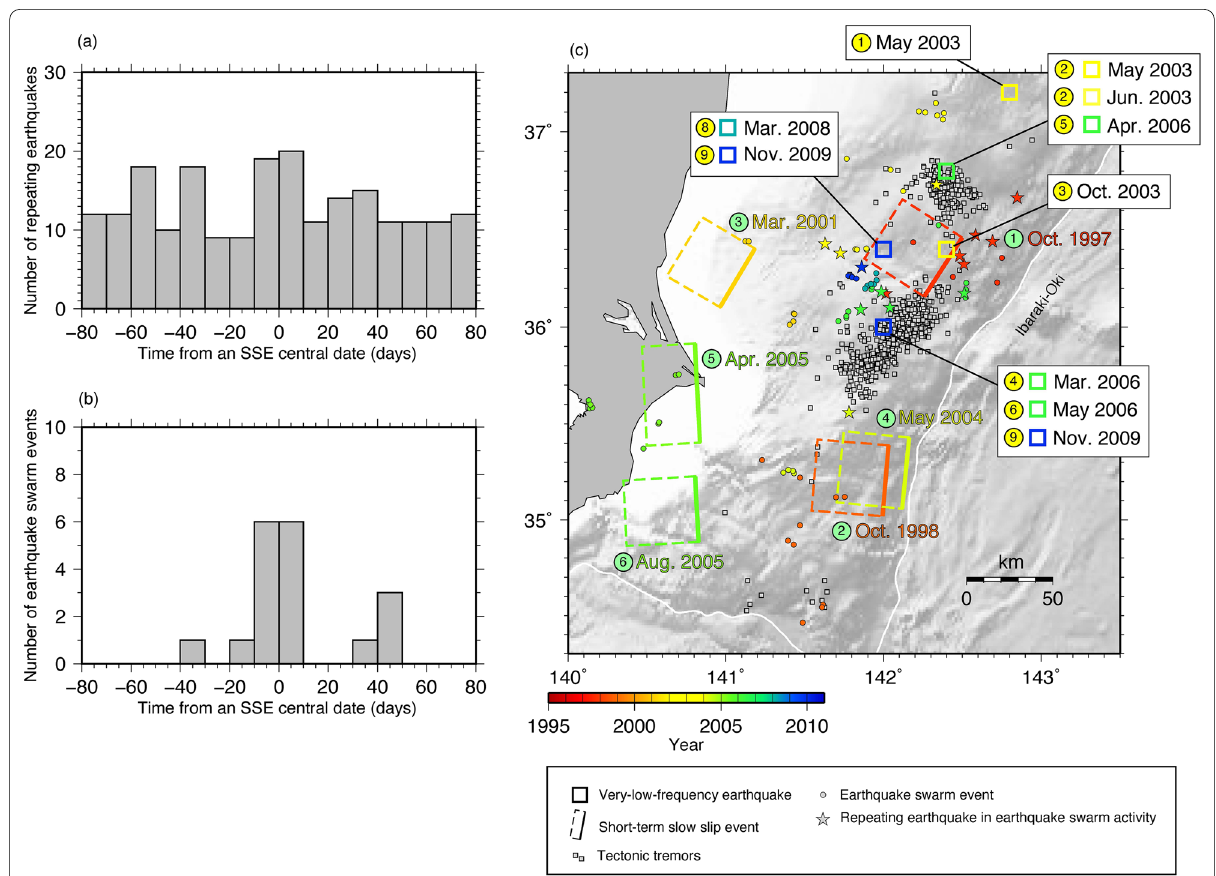
Fig. 8 Coinciding events of repeating earthquakes, earthquake swarms, and slow earthquakes in the southern Japan Trench. a and b Histograms of the occurrence times of repeating earthquakes and earthquake swarm events, respectively, relative to an SSE central date. These repeating earthquakes and earthquake swarm events occurred inside the SSE fault models or within 20 km of the fault models. c Epicenters of the coincident events. The coincident events of earthquake swarms and SSEs are indicated by numbers 1–6 in green, as in Fig. 7b. The coinciding events of earthquake swarms and VLFEs are indicated by numbers 1–9 in yellow, as in Fig. 7b. The VLFEs are from Baba et al. (2020). Note that the VLFEs sometimes have identical epicenters because they were detected using a matched filter technique (Baba et al. 2020). The short-term SSEs are from Nishimura (2021). Tectonic tremors are from Nishikawa et al. (2019) and this study. Repeating earthquakes are based on Uchida and Matsuzawa (2013). The earthquake swarms are from Nishikawa and Ide (2018) and Nishikawa et al. (2019). The VLFEs, SSEs, earthquake swarm events, and repeating earthquakes are colored according to their occurrence